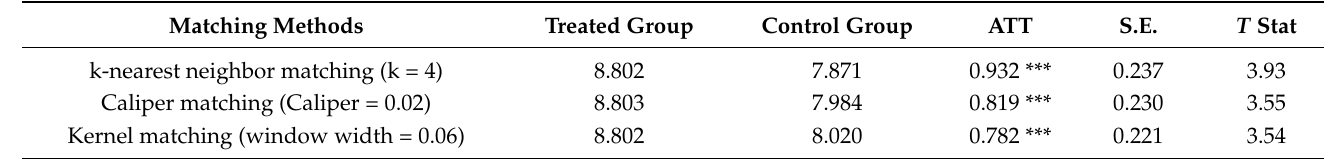
Table 4. Estimation results of the PSM